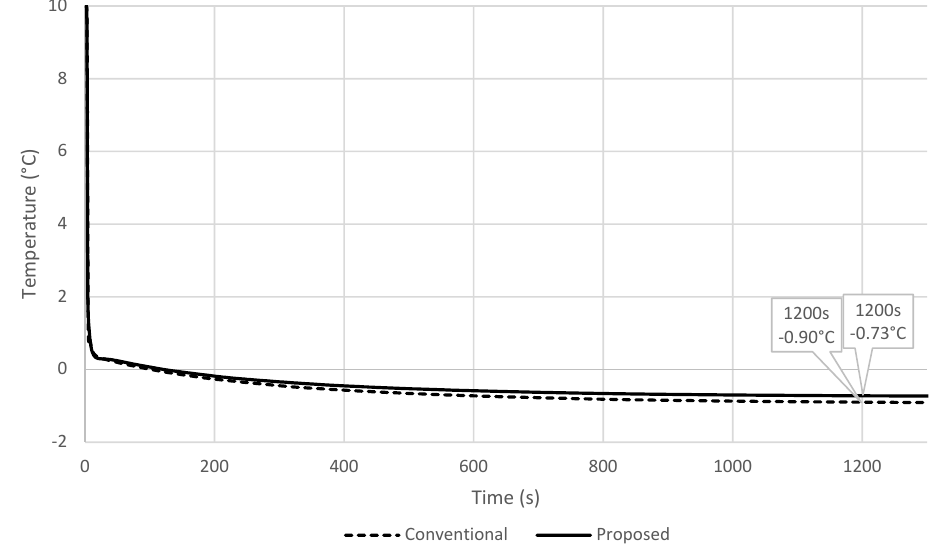
Figure 10. Average outtake air temperature at the middle plane as a function of operating time.